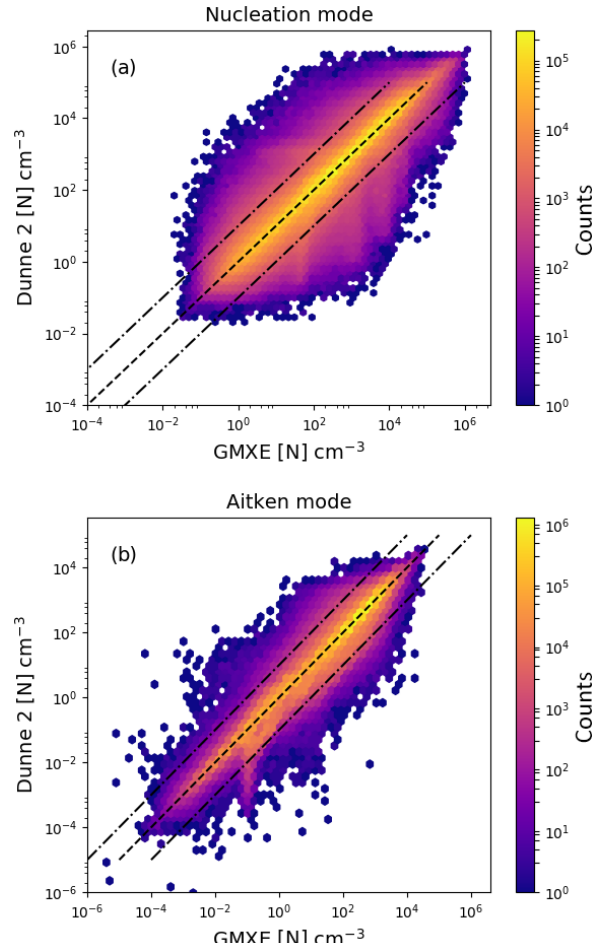
Figure 5. Logarithm of the aerosol particle number concentra- tion with the Dunne et al. (2016) nucleation scheme implemented in NAN and called in EMAC just before the call of GMXe ( y axis) vs. implementation inside the GMXe submodel ( x axis). Panel (a) shows the results for nucleation-mode particles and panel (b) for Aitken-mode particles. The colour indicates the total number of counts in each hexagonal bin.